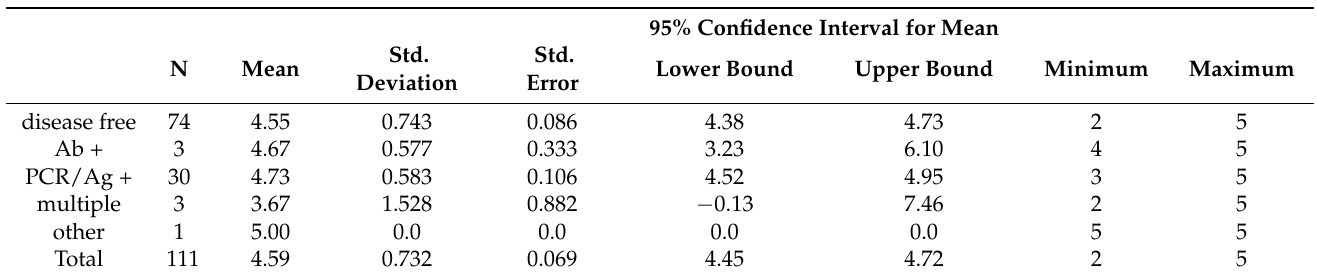
Table 2. Biosafety feeling of patients during dental procedures, full data available in supplementary